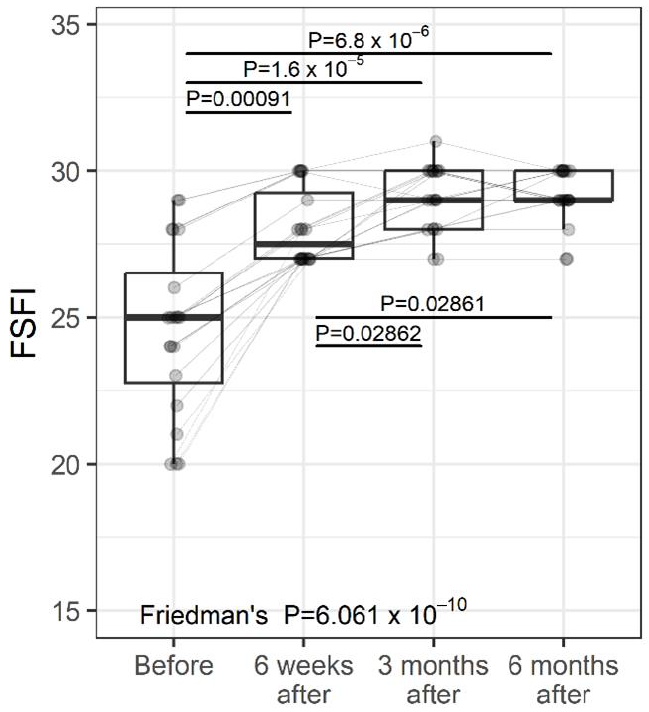
Figure 2. FSFI (Female Sexual Function Index) at study entry and follow-up visits (individual values and summary statistics).